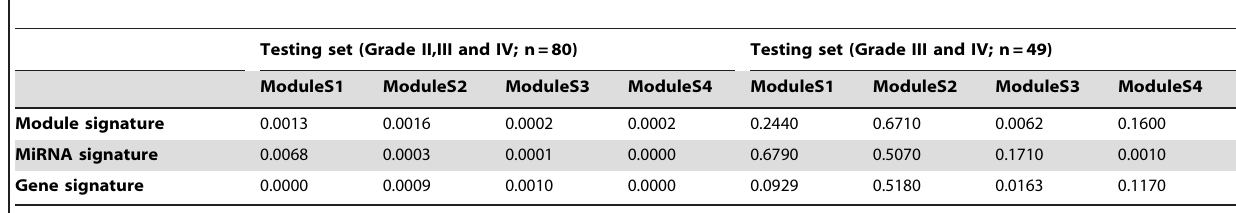
Table 3. The P-value performance of four sub-modules using Kaplan-Meier survival analysis in the testing set.